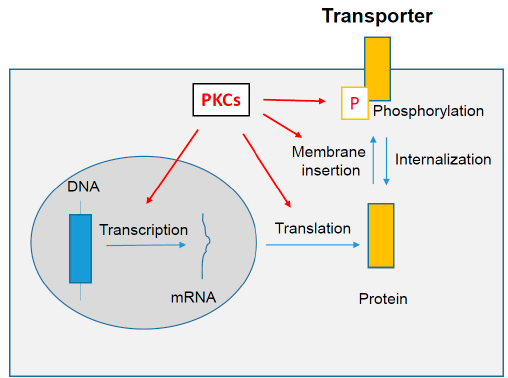
Figure 1. Schematic representation of putative cellular targets of protein kinases C (PKCs, in red) with respect to regulation of drug transporter activity, localization and/or expression. Arrows in red indicate the putative effects of PKCs on transporter regulatory pathways. Arrows in blue correspond to the different transporter processing steps, from gene (DNA) to activity regulation at the plasma membrane by phosphorylation (P, in red). DNA: deoxyribonucleic acid; mRNA: messenger ribonucleic acid.